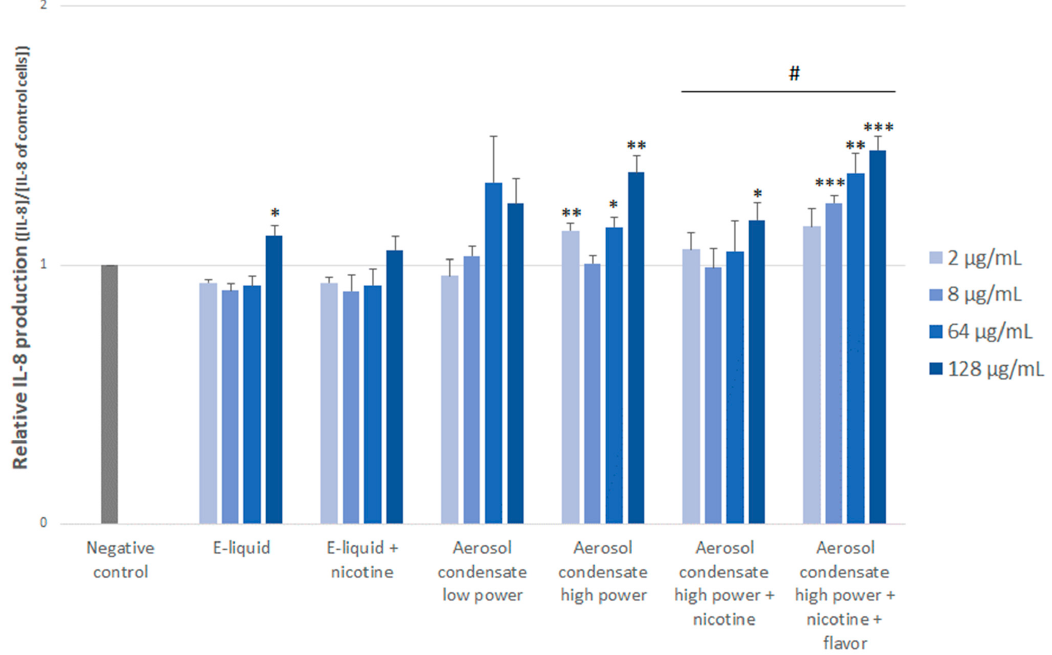
Figure 4. Relative IL-8 production induced by the different experimental conditions and assessed after 24 h of cell exposure. Results are expressed relative to control (unexposed) cells and are means of three independent experiments, each performed in duplicate. Statistical significance is also indi- cated: * p < 0.05, ** p < 0.01, *** p < 0.001 as determined with a two-sided Student’s t -test between control and experimental groups. For inter-group comparisons, an ANOVA analysis was per- formed: # p =